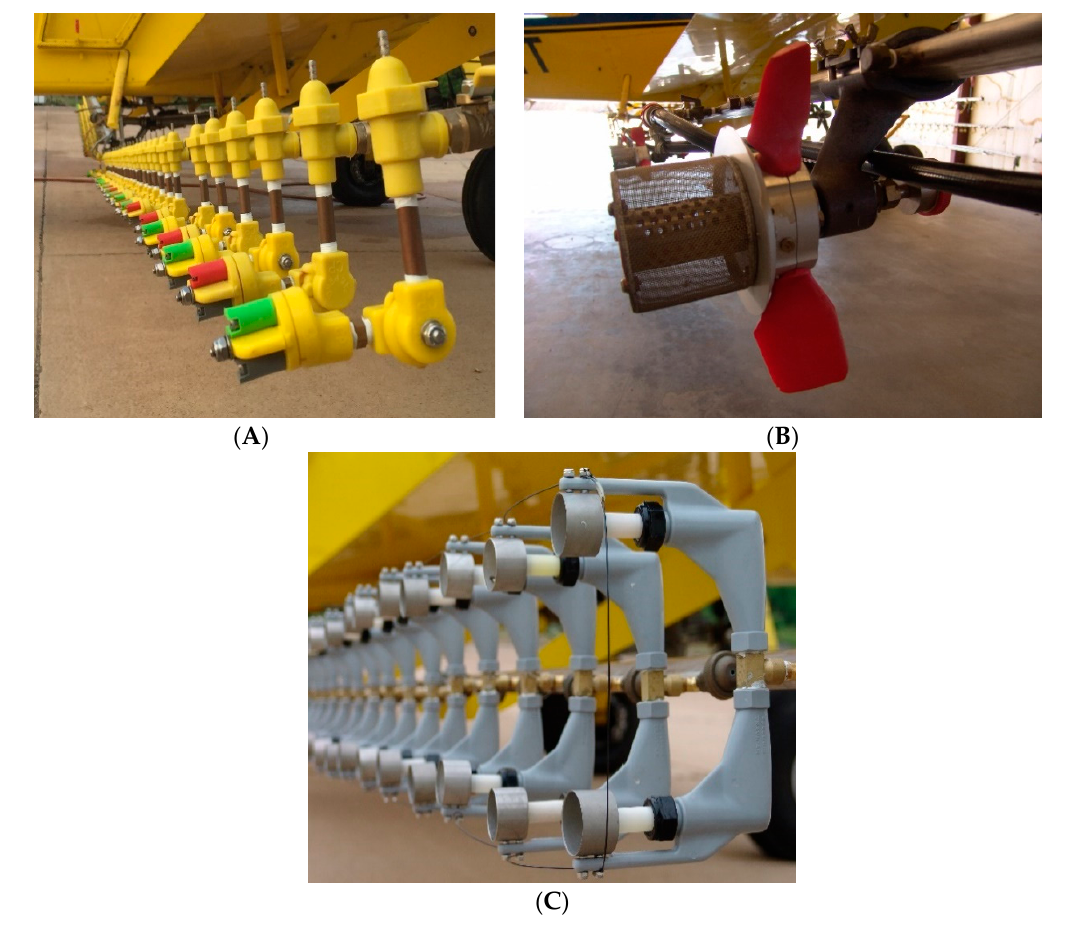
Figure 3. Aerial nozzles used in the study: CP ( A ), Rotary ( B ), and Electrostatic ( C ). Table 1. Spray treatment setups and droplet size